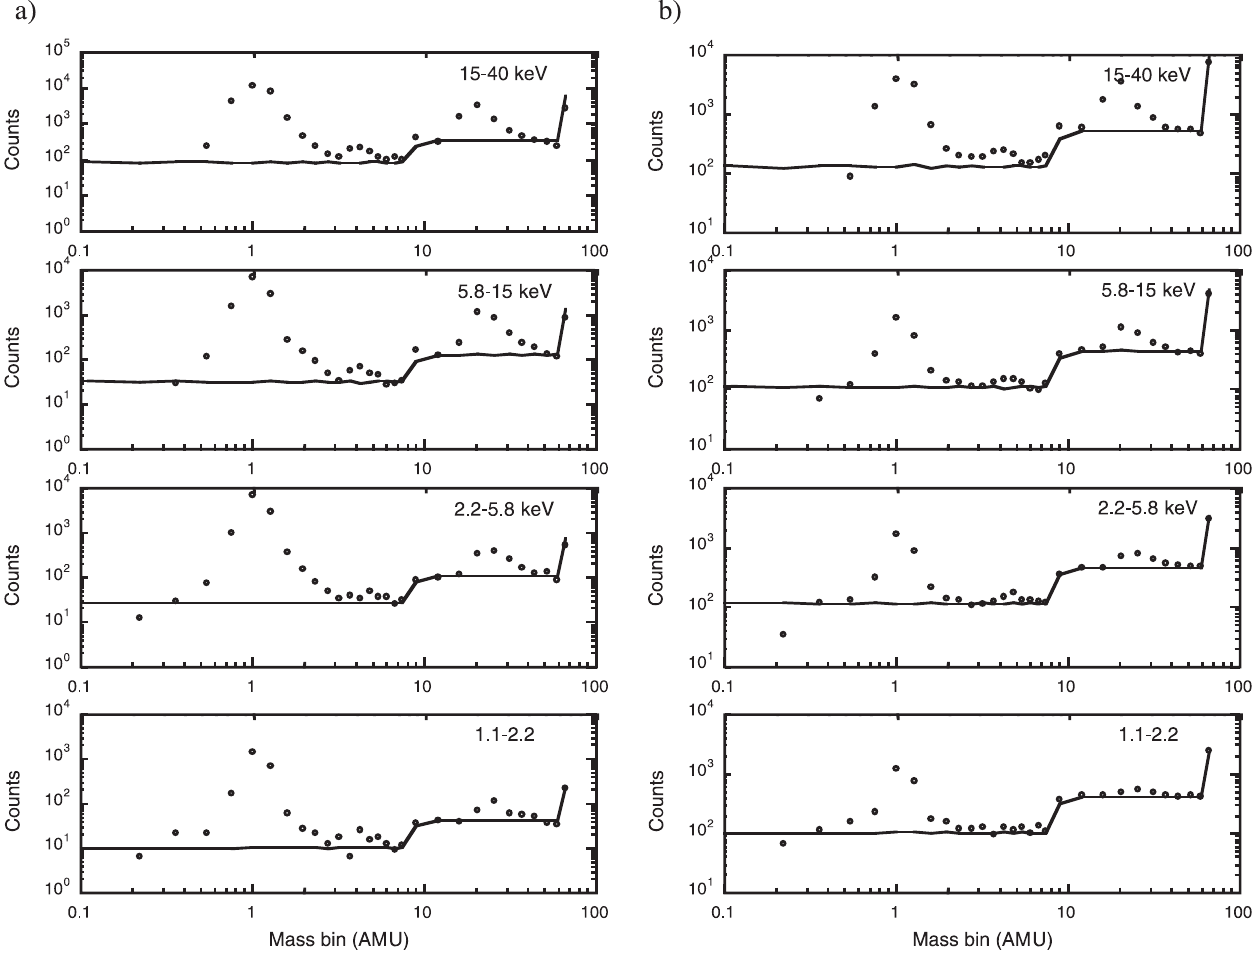
Fig. 1. a Mass distributions at L = 5.75 for four energy ranges. The solid line gives the background level. The jump in background observed at 9 AMU is due to a discontinuity in the mass algorithm. b Mass distributions at L = 4.25 in the same format as